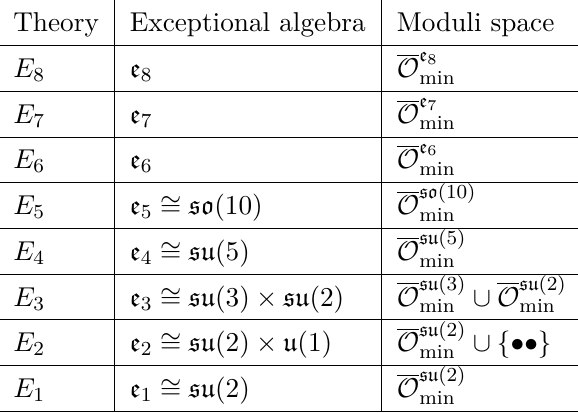
Table 5. The rank-1 exceptional E n theories have their Higgs branch equal to the closure of the minimal nilpotent orbit of the e n algebras. For lower ranks, the respective moduli spaces are identified in [17].